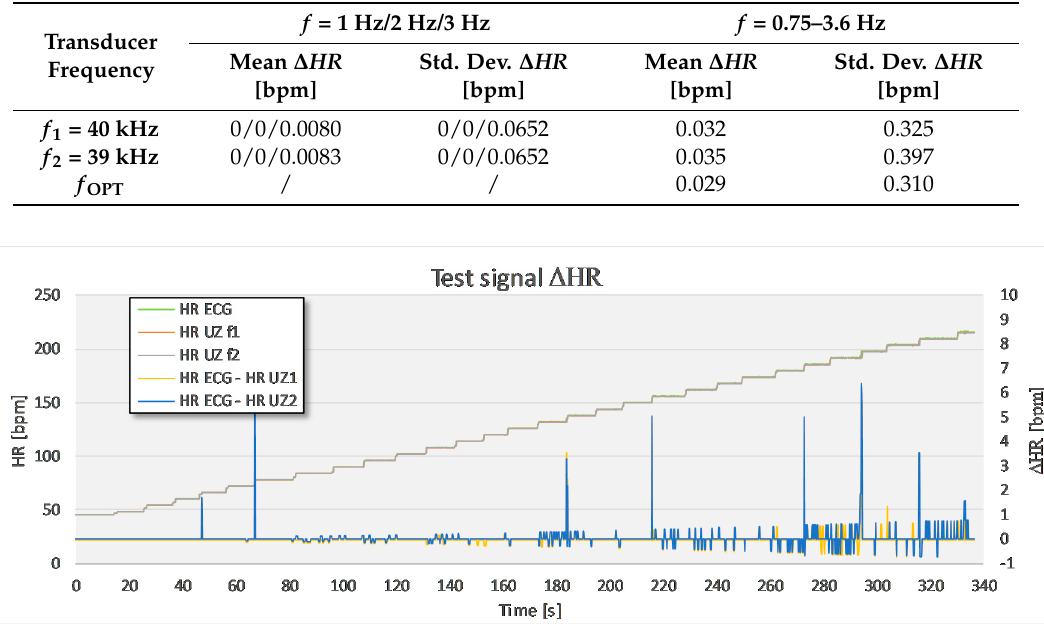
Table 1. Mean and standard deviation of the differences between the instantaneous HR obtained with the experimental method at different frequencies ( f OPT = optimal frequency selected in real time) and the reference method.